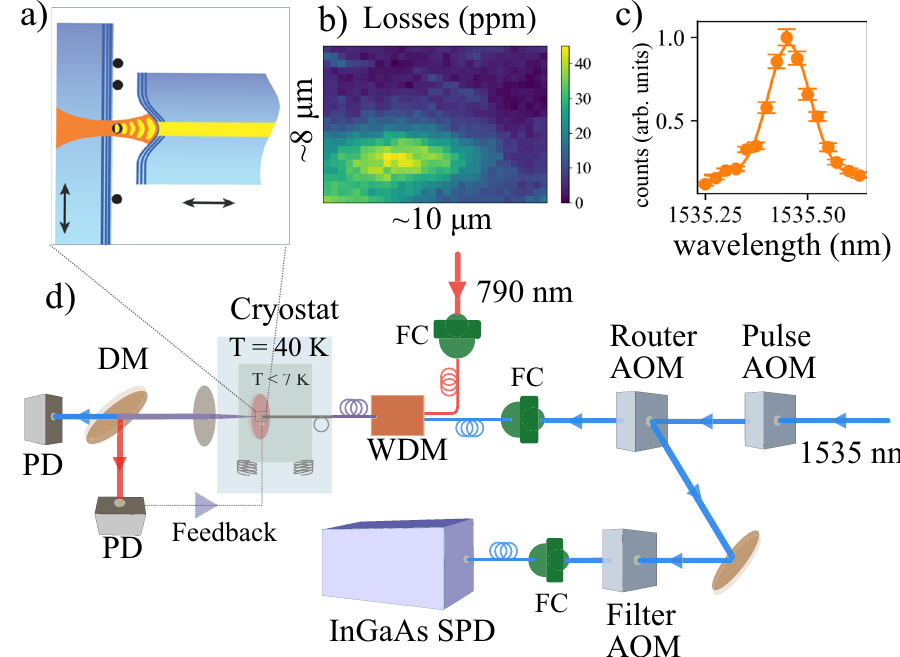
Fig. 1 Description of the experiment. a Schematic drawing of the tunable fi ber-based microcavity. The fi ber mirror can be moved in 3D, allowing us to set the length of the cavity and locate a nanoparticle inside the cavity. b Map of scattering loss introduced by a single nanoparticle when scanning the cavity mode across it. c Measurement of the inhomogeneous line of the 4 I 15/2 – 4 I 13/2 transition. The solid line is a Gaussian fi t, yielding a full-width-half-maximum linewidth of 15(2) GHz (error bars represent one standard deviation). d The optical setup is described in more detail in the SI. In summary, a 1535-nm laser is used to excite the ions and a 790-nm laser to stabilize the length of the cavity. The two lasers are combined using a wavelength division multiplexer (WDM). A set of acousto-optic modulators (AOM) are used to create pulses from the CW excitation laser, to route the excitation light to the cavity and the cavity photons to the detector, and to suppress the excitation light to the single-photon detector (SPD) by 60 dB (InGaAs, detection ef fi ciency 10%) during excitation. DM is a 780/1535nm dichroic mirror, PD are continuous avalanche photo-diodes (APD) for cavity length stabilization and transmission